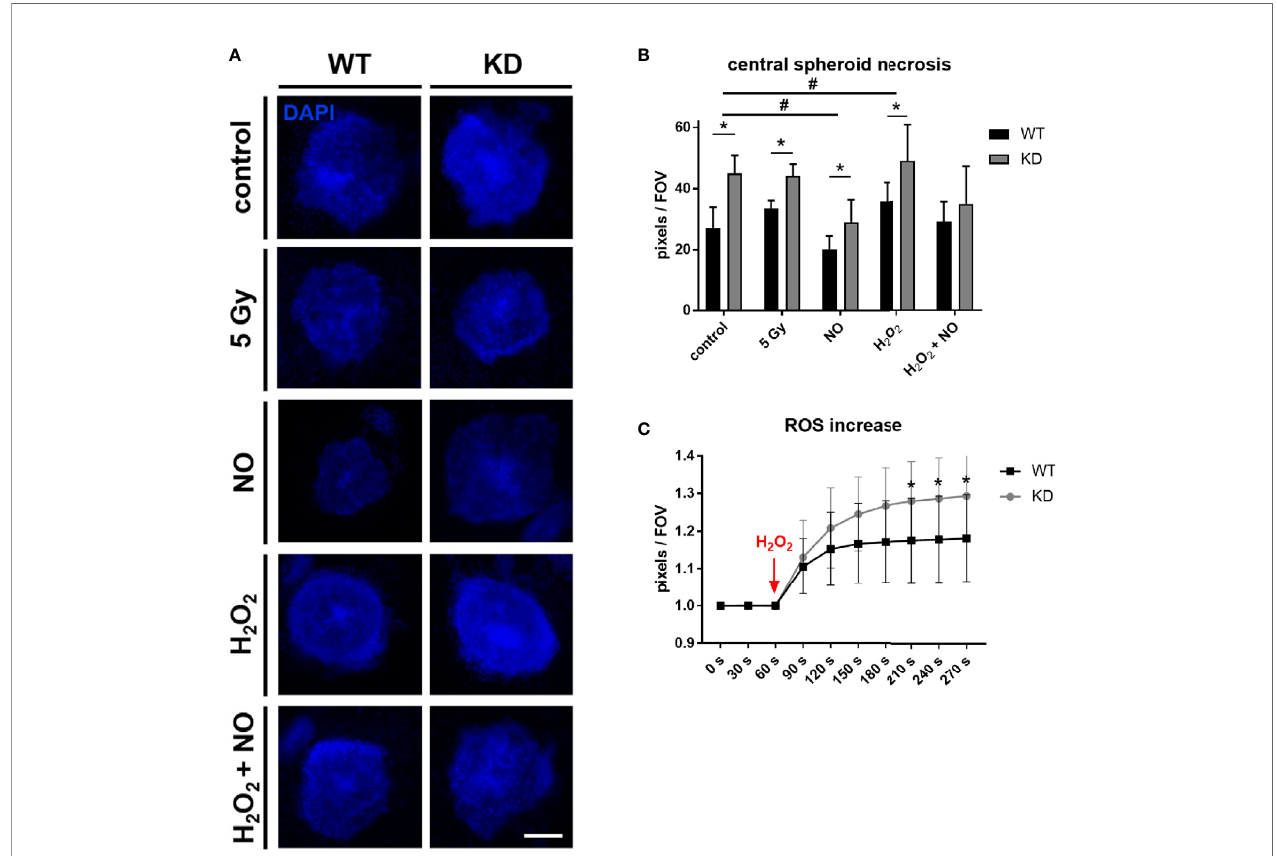
FIGURE 3 | Effect of MB in oxidative stress. (A, B) WT and MB KD MDA-MB-468 spheroids were challenged with different substances inducing oxidative stress. 24 h after transfection with Hs_MB_6 FlexiTube siRNA (KD) or control siRNA (WT), cells were either left untreated (control), irradiated with 5 Gy or treated with 500 μM nitric oxide (NO), 100 μM hydrogen peroxide (H 2 O 2 ) or a combination of both for 4 h. Central necrosis of spheroids was visualized by DAPI intake. NO treatment led to an overall reduction in central necrotic cells whereas H 2 O 2 treatment enhanced cellular death. Still, MB protected cells from dying in all tested conditions. Scale bar = 50 μm. Results are shown as pixels/ fi eld of view (FOV), mean +/- sd, n = 7-11 in 2 independent experiments, *p < 0.05 between genotypes; # p < 0.05 between treatment conditions. (C) 24 h after fi rst transfection, WT and KD MDA-MB-468 monolayer cells were re-transfected with pC1-HyPer3, incubated for another 24 h under normoxia and fi nally challenged with 100 μM H 2 O 2 to simulate hypoxic stress leading to an increased ROS formation. ROS levels were measured as changes in fl uorescence of the HyPer3 plasmid during live cell imaging over a period of 270 s. Myoglobin knockdown led to signi fi cantly higher ROS levels in the cells after treatment with 100 μM H 2 O 2 . Mean +/- sd, n = 12 in 2 independent